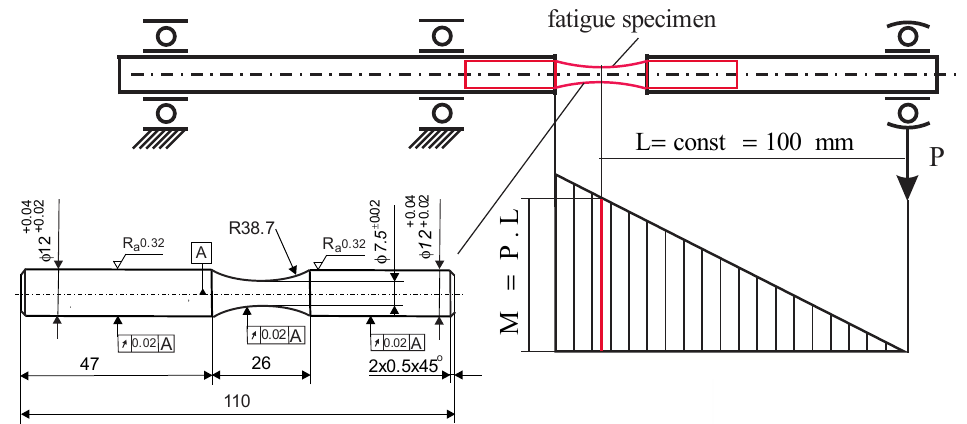
Figure 5. Specimen geometry (the sizes are in mm) and rotating bending fatigue test scheme.